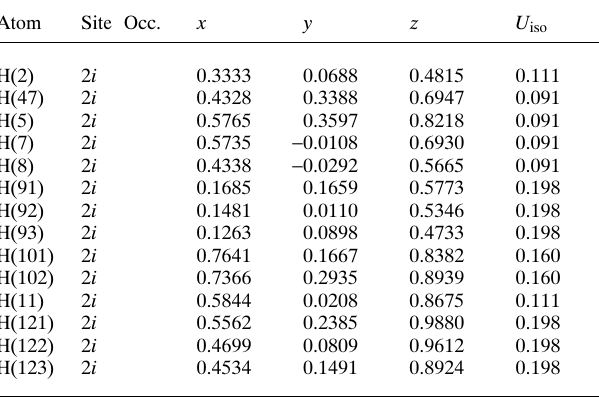
Table 2. Atomic coordinates and displacement parameters (in Å 2 ) . Atom Site